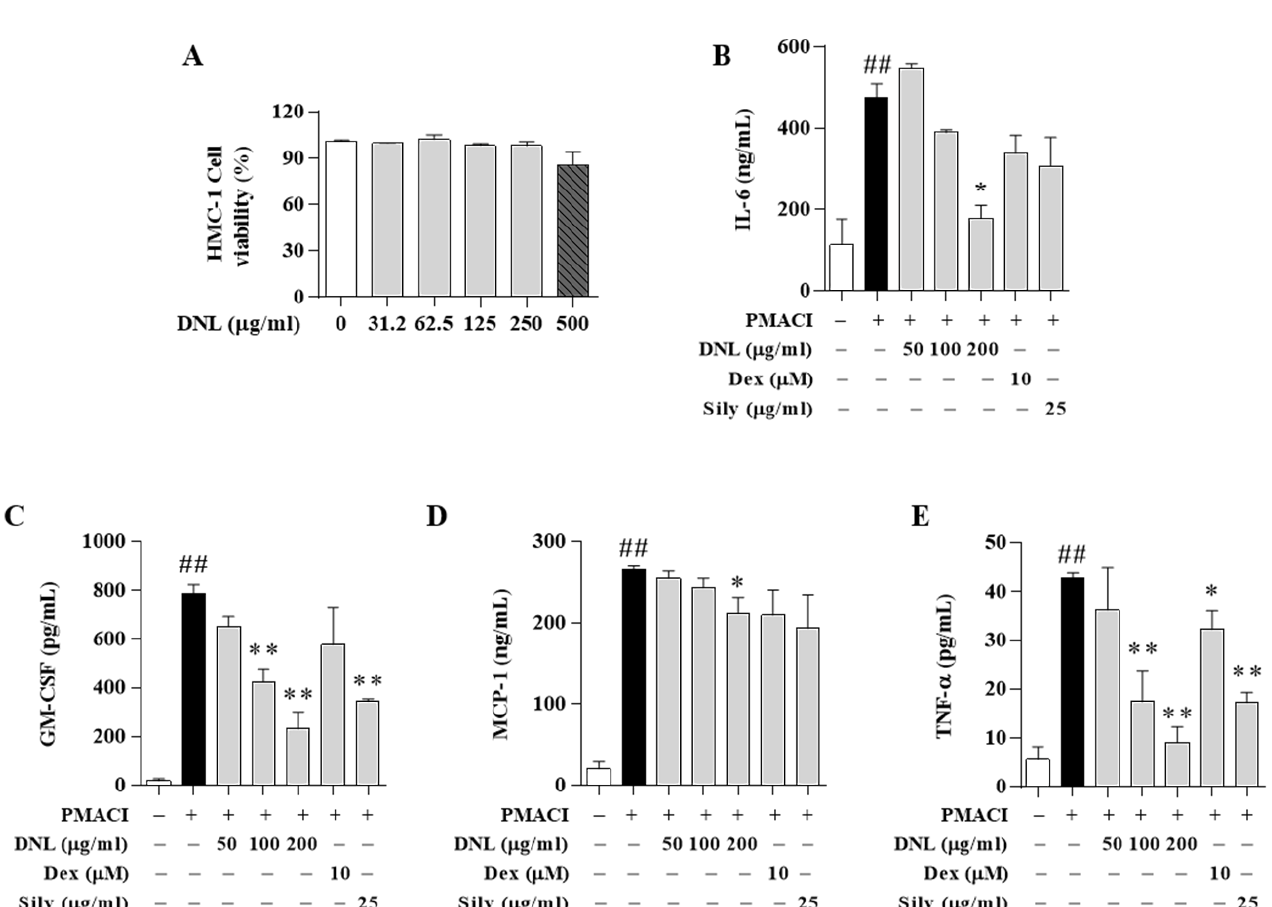
Figure 6. Effects of DNL on inflammatory chemokines and cytokines in PMACI-induced HMC-1 cells. ( A ) Viability of DNL in HMC-1 cells. After treating HMC-1 cells with various concentrations of DNL, they were reacted for 24 h, and then MTS analysis was performed. ( B – E ) Expression of inflammatory chemokines and cytokines was confirmed by ELISA in PMACI-induced HMC-1 cells. The data are expressed as mean ± SEM ( n = 3). ## p < 0.01, compared with the normal group. * p < 0.05 and ** p < 0.01, compared with the control group.